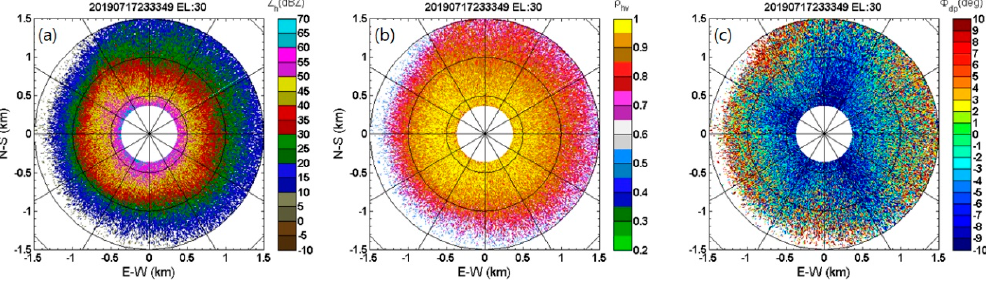
Figure 10. Rainfall observation image obtained using the EWRG (2019 / 07 / 17 23:33:49, Geoje), ( a ) Reflectivity (Z h ); ( b ) Correlation Coefficient ( ρ hv ); and ( c ) Differential Phase Shift ( Φ dp ).